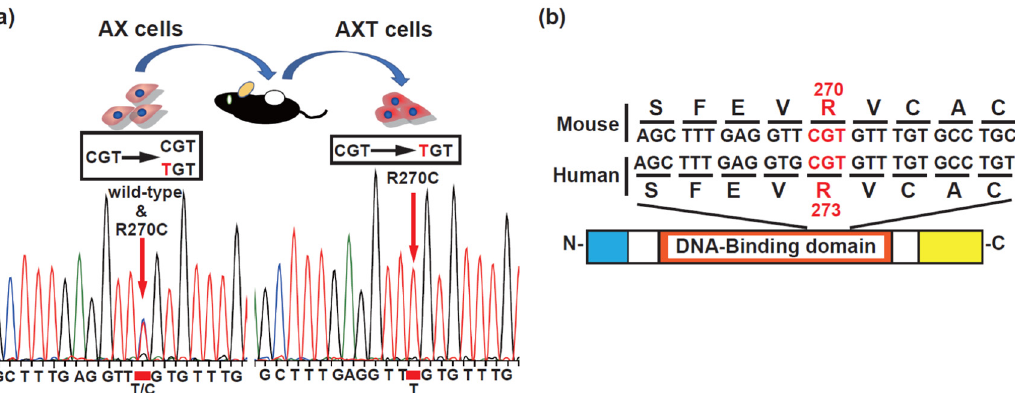
Figure 1. AX and AXT cells contain R270C mutant p53. ( a ) AX and AXT cells contain a missense mutation in the DNA-binding domain that occurs as a result of amino acid substitution. ( b ) A comparison of mouse Trp53 and human TP53 sequences at the mutation site. The red text indicates the mutated codon.